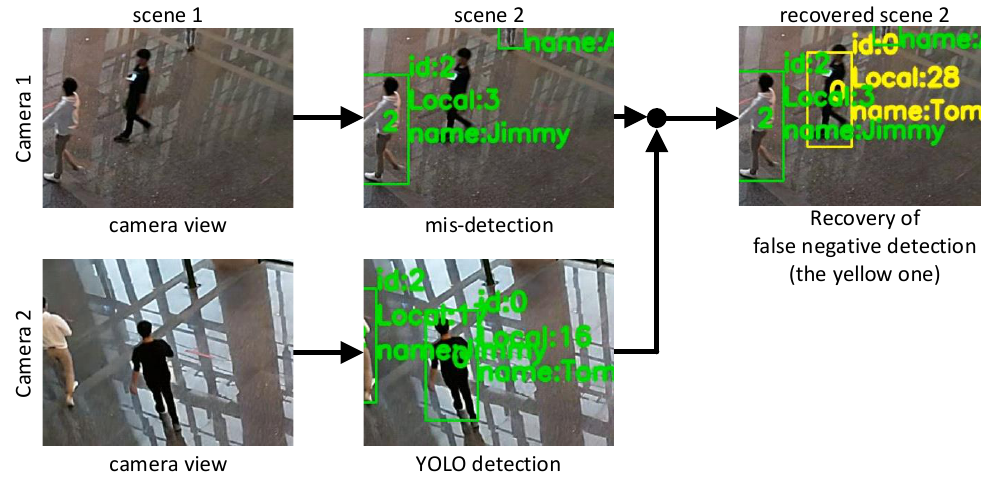
Figure 11. False negative recovery scenario.